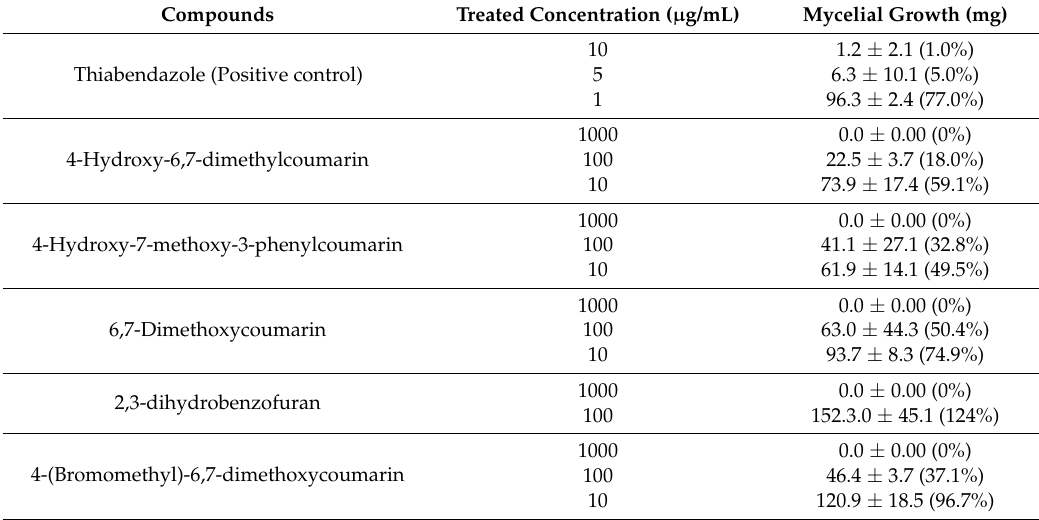
Table 1. Mycelial growth of Aspergillus flavus treated with various coumarins. Compounds Treated Concentration ( µ g/mL) Mycelial Growth (mg) Thiabendazole (Positive control)